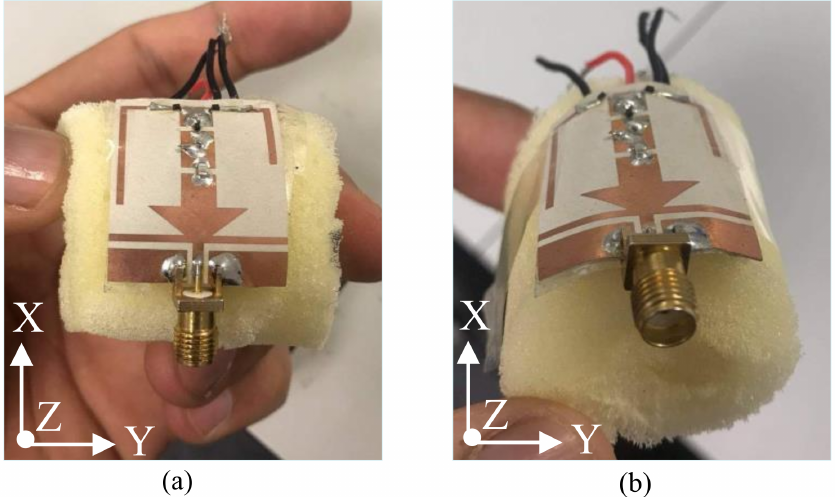
Figure 10. Bending conditions of the proposed filtenna along ( a ) x -axis and ( b ) y -axis. The simulated and measured gain in passbands along with a simulated radiation efficiency are shown in Figure 17. For all possible operating states, the antenna offers a measured gain of more than 2 dBi in the lower resonating frequencies, while at higher frequencies it is around 3 dBi. Similarly, the antenna has a radiation efficiency of >87% for all diode switching states, depicting the operation stability of the